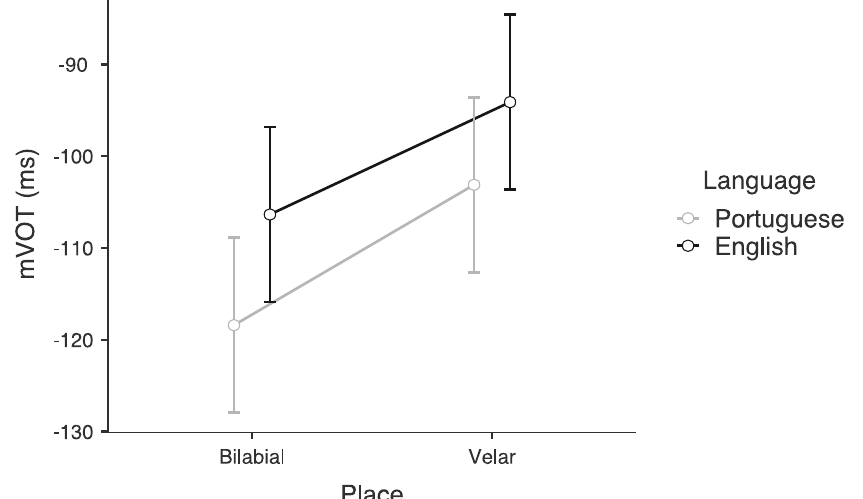
Figure 3. Mean (and 95% CI) mVOT values plotted as a function of place (bilabial, velar) and language (L2 English, L1 Portuguese). Data come from 28 native speakers of Portuguese learning English as a foreign language in Brazil. The sample includes only voiced plosives with prevoicing.